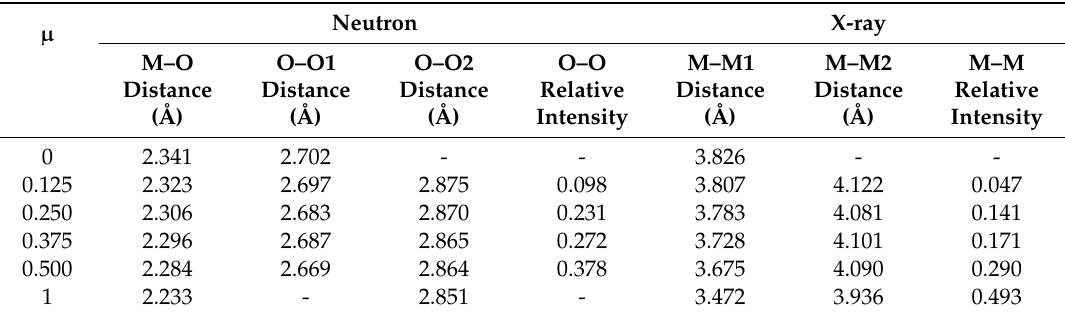
Figure 4. ( a ) Neutron and ( b ) X-ray experimental Pair Distribution Function (PDF) curves at 90 K. The dashed line in panel ( a ) is a guide to the eye for a second O–O pair; the one in panel ( b ) stands for a second M–M pair. Table 2. Selected interatomic distances from neutron and X-ray, computed by direct analysis of PDF